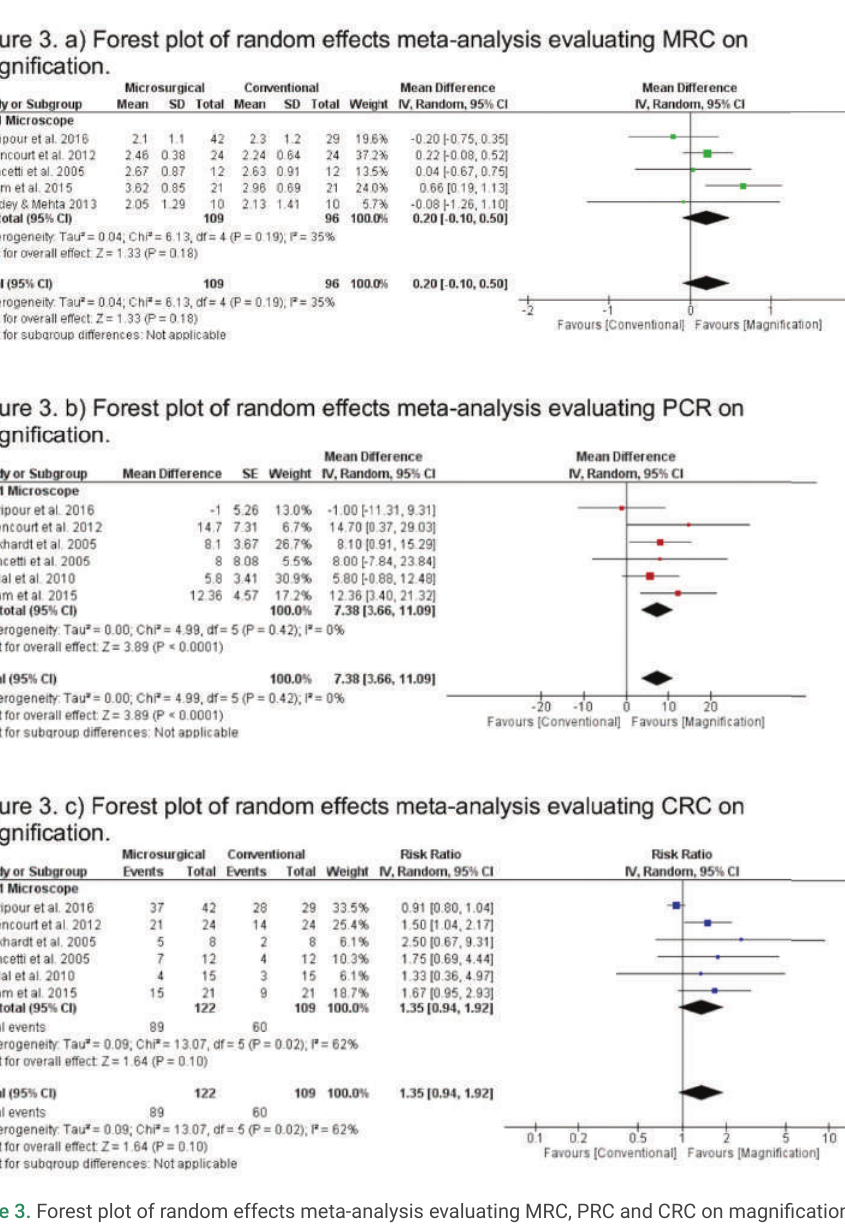
Figure 3. Forest plot of random effects meta-analysis evaluating MRC, PRC and CRC on